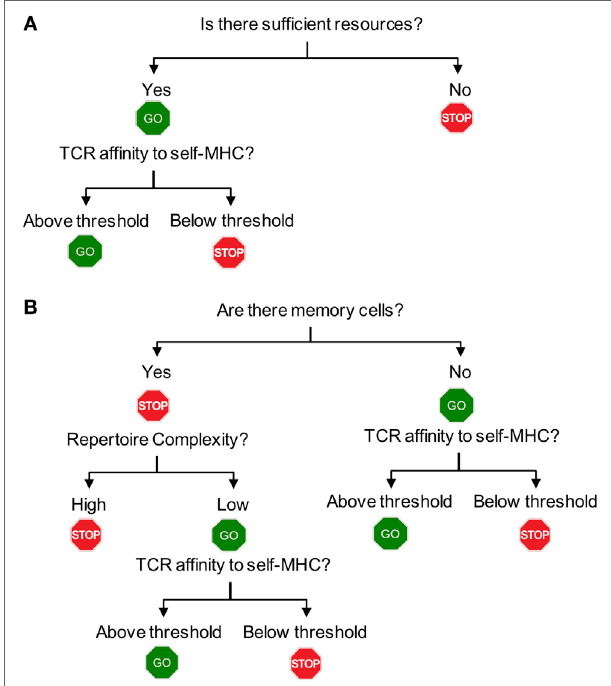
FiGURe 2 | Flowchart for homeostatic and spontaneous proliferation. (A) Homeostatic proliferation. The first step for T cells to check is whether there is sufficient homeostatic factor available. Once the source is available, then the relative affinity of each T cells expresses against MHC-self-antigens (or exogenous antigen as well) will determine proliferation. (B) Spontaneous proliferation. Unlike homeostatic proliferation, the first step deciding spontaneous proliferation is whether there is a memory population in the periphery. The lack of any memory population triggers a full blown spontaneous proliferation during which T cells with higher affinity to MHC-self-antigens (and commensal antigens) are induced for proliferation. If there is a population of pre-existing memory cells, the complexity of T cell receptors (TCR) repertoire will then become the next step determining proliferation. Only incomplete repertoire complexity of memory cells will allow spontaneous proliferation to occur. The final decision will depend upon the TCR that each T cell expresses. Only if the TCR strength toward endogenous peptides (self or commensal) is above threshold, they will be allowed to undergo